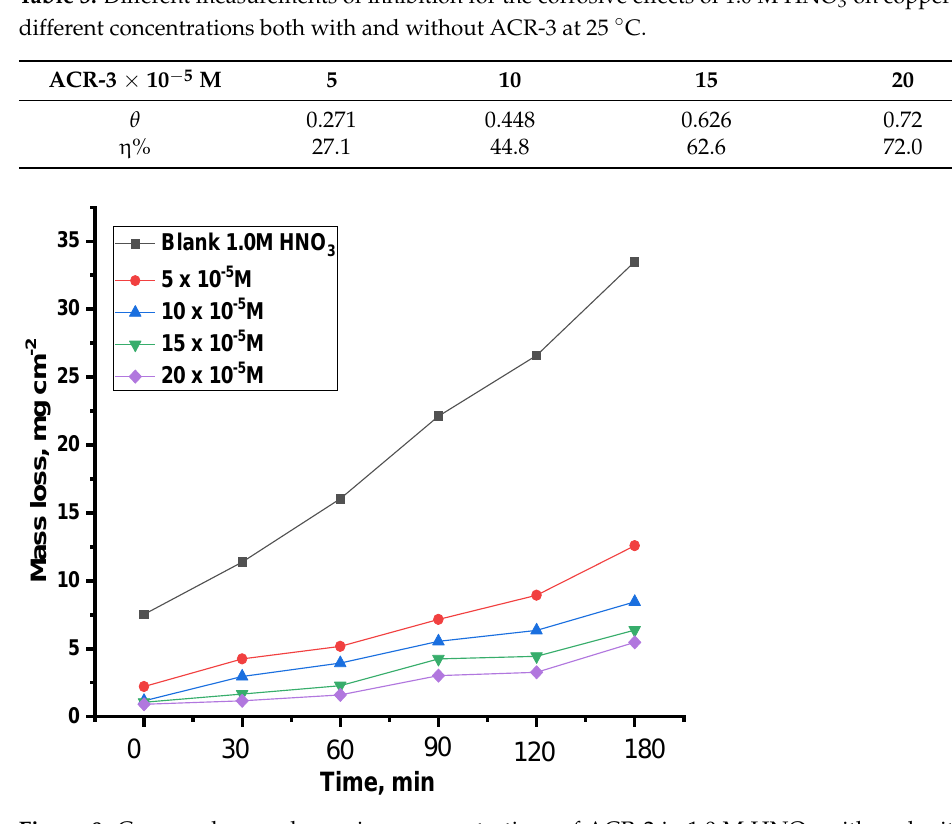
Figure 8. Cu mass loss under various concentrations of ACR-2 in 1.0 M HNO 3 with and without immersion